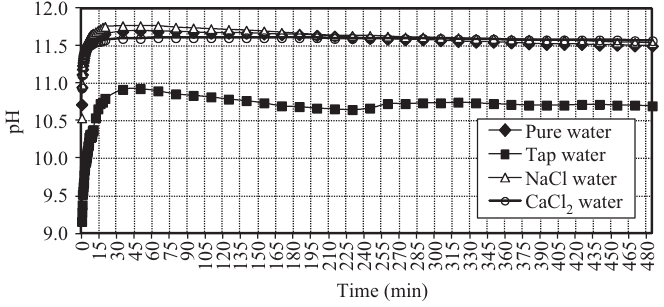
Figure 6 pH values of cement pastes vs. time.